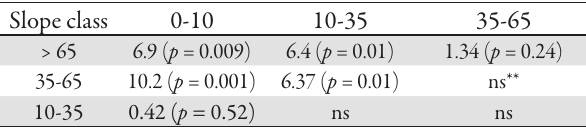
Tab. 3. Multiple comparison between percentage cover of vegetation and slope percentage*